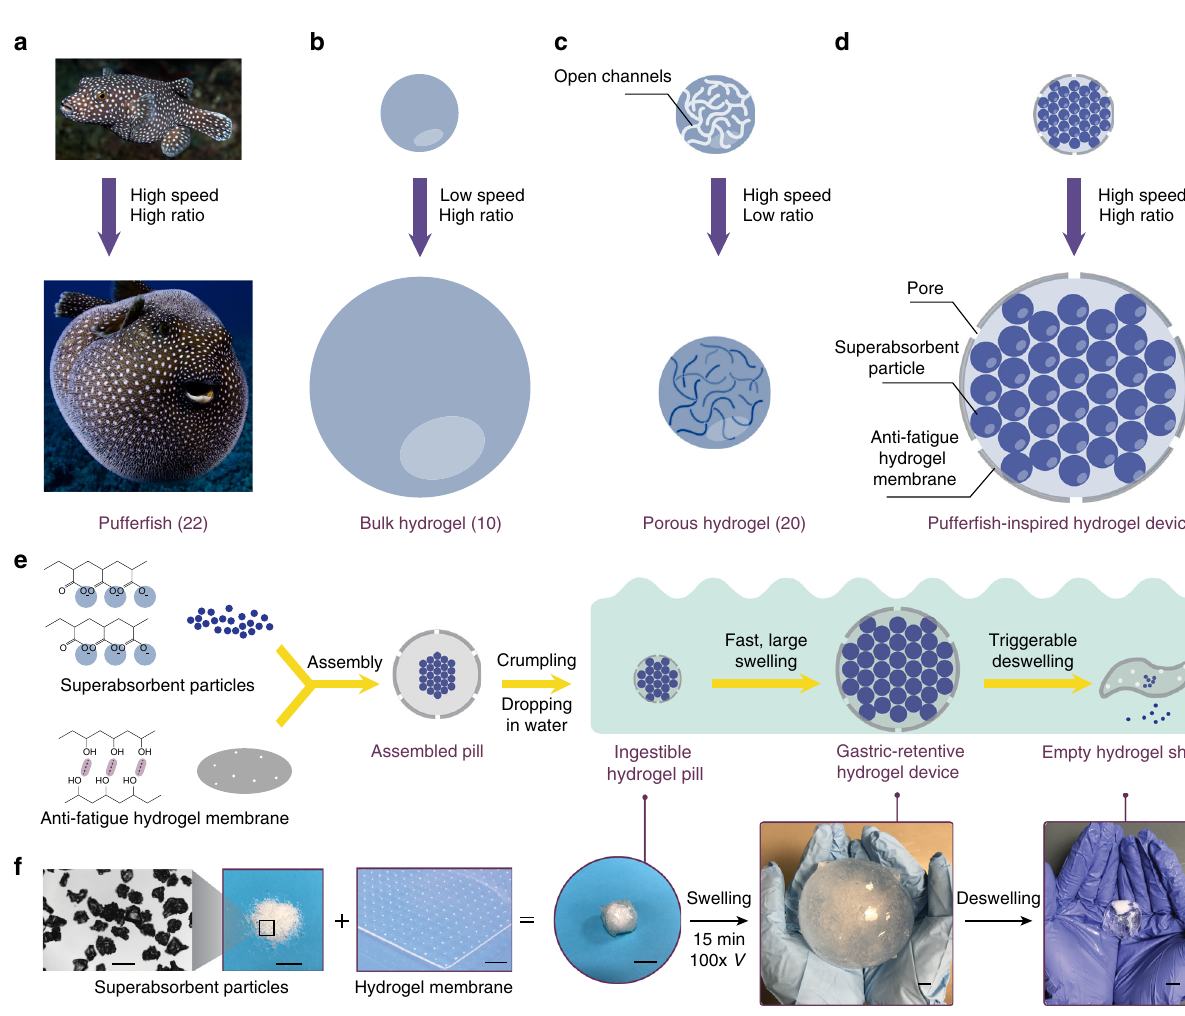
Fig. 1 Design of the puffer fi sh-inspired ingestible hydrogel device. a A puffer fi sh in fl ates its body into a large ball by rapidly imbibing water 22 . b Bulk hydrogels swell in water with a low swelling speed 10 . c Porous hydrogels swell in water with a low swelling ratio 20 . d The designed hydrogel device swells in water with both a high speed and a high ratio. e Schematic of the fabrication process and working principle of the designed hydrogel device. f Photographs of the fabrication process and working principle of the designed hydrogel device. Scale bars are 0.5 mm for the fi rst image in ( f ) and 10 mm for the other images in ( f